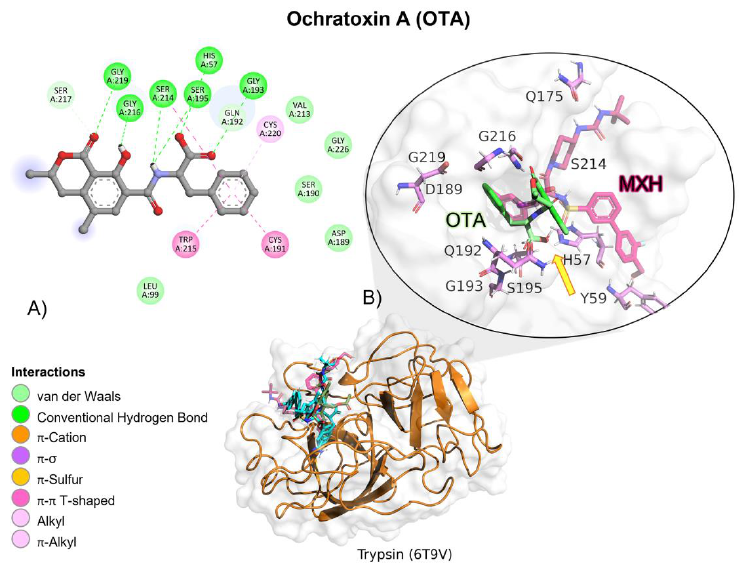
Figure 14. Ochratoxin (OTA) — trypsin interactions. ( A ) Panoramic view of the reference (MXH) and the tested OTA ligands within the trypsin binding site showing the docked poses of the tested and reference ligands. ( B ) Detailed view showing the interactions of the different amino acid residues within the binding site of trypsin with the OTA ligand. The yellow arrow shows the proximity between the trypsin catalytic triad and the OTA amide bond, suggesting its breakup.